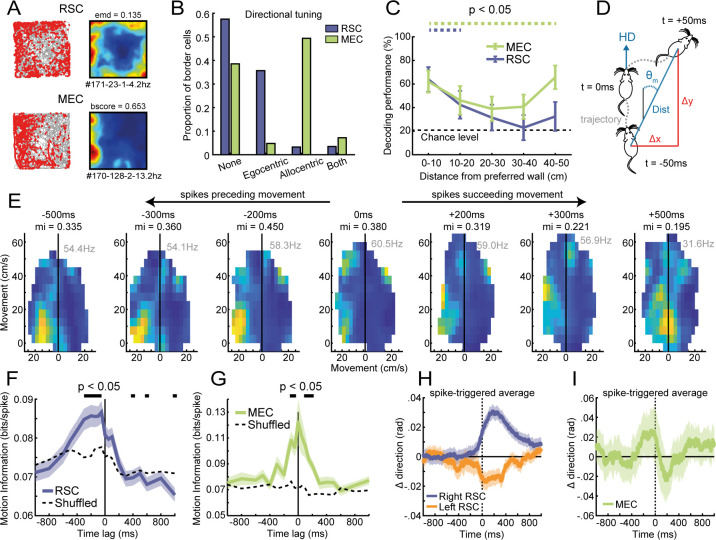
Firing of RSC border cells provides local boundary information and is correlated with the animal’s future motion.(A) Spike trajectory plots and spatial rate maps of typical border cells recorded in RSC and MEC. (B) Proportion of border cells in RSC and MEC that had significant directional tuning to allocentric head-direction or egocentric boundary-direction. (C) A decoder using a support vector machine (SVM) classifier estimated the animal's distance to the wall based on population spiking activity. Local distance information was present in both regions but extended further into the center of the arena only in MEC. (D) Self-motion maps were computed based on short trajectories of the animal, giving lateral and frontal displacements (Δx and Δy, respectively) and distance traveled, Dist, in 100 ms time bins relative to the animal’s forward head-direction, giving a self-centered moving direction, θm, at each timepoint. (E) Example motion map of an RSC border cell with spike times shifted in time relative to the animal’s motion data. A firing field emerged on left turns when spikes were shifted −200 to −500 ms before motion. (F) RSC border cells fired prospective to motion, where the amount of information present in motion maps is maximal when spike timings were shifted −50 to −300 ms earlier. (G) MEC border cells by contrast did not show any prospective or retrospective activity. (H) Spike-triggered average of changes in direction, calculated as the difference of moving directions in 250 ms bins, where positive values indicate right turns. RSC spikes preceded turning behavior of the animal by ~200 ms, with border cells in opposing hemispheres firing prospectively to ipsilateral turns. (I) MEC spikes by contrast were not locked to any change in the animal’s behavior. *p<0.05, t-test.